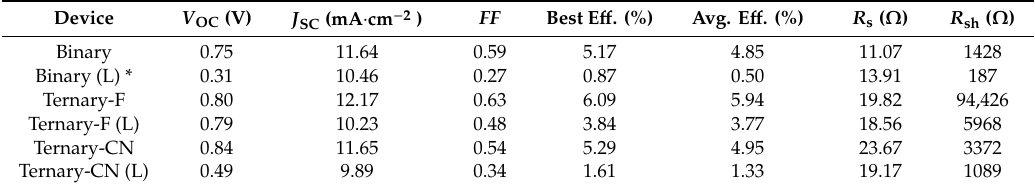
Figure 2. Current density vs. voltage curves for the fabricated SM-OPV devices ( a ) before and ( b ) after 1 sunlight soaking for 1500 h. ( c ) External quantum e ffi ciency (EQE) spectra before the light soaking. Table 1. Solar cell parameters of the fabricated SM-OPV devices before and after 1 sunlight soaking for 1500